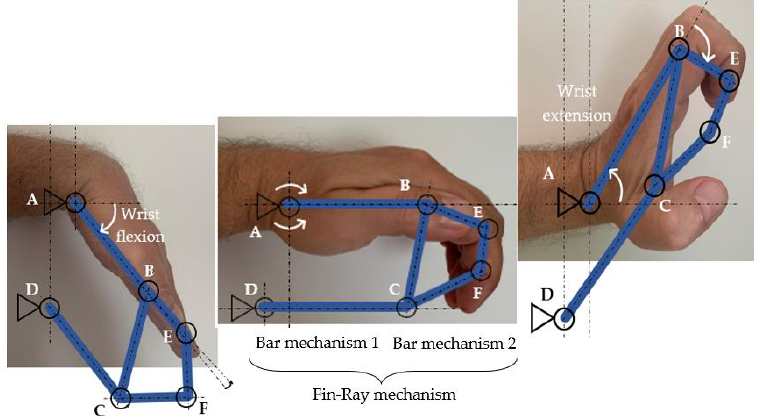
Figure 3. Motions of the hand support.